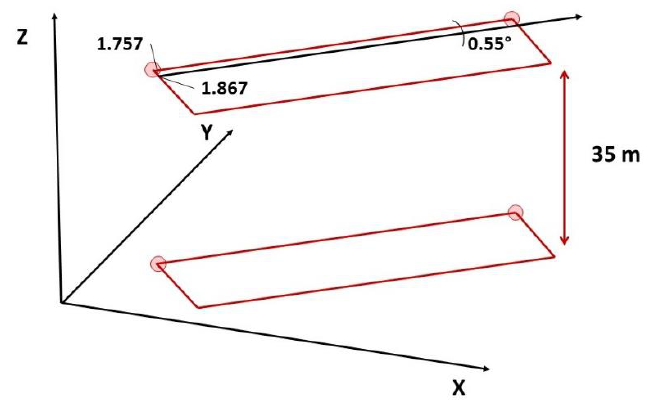
Figure 21. LiDAR point correction for the Z axis.